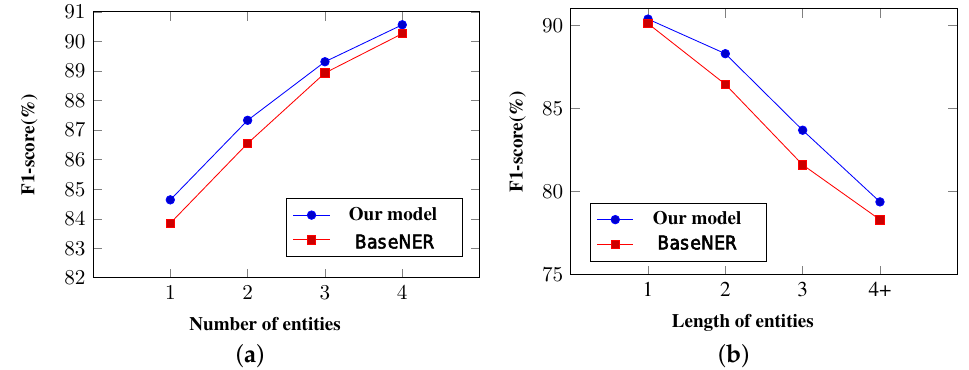
Figure 7. F 1 -score against entity length and sentential entity number on the OntoNotes test set. ( a ) Sentential entity number. ( b ) Entity